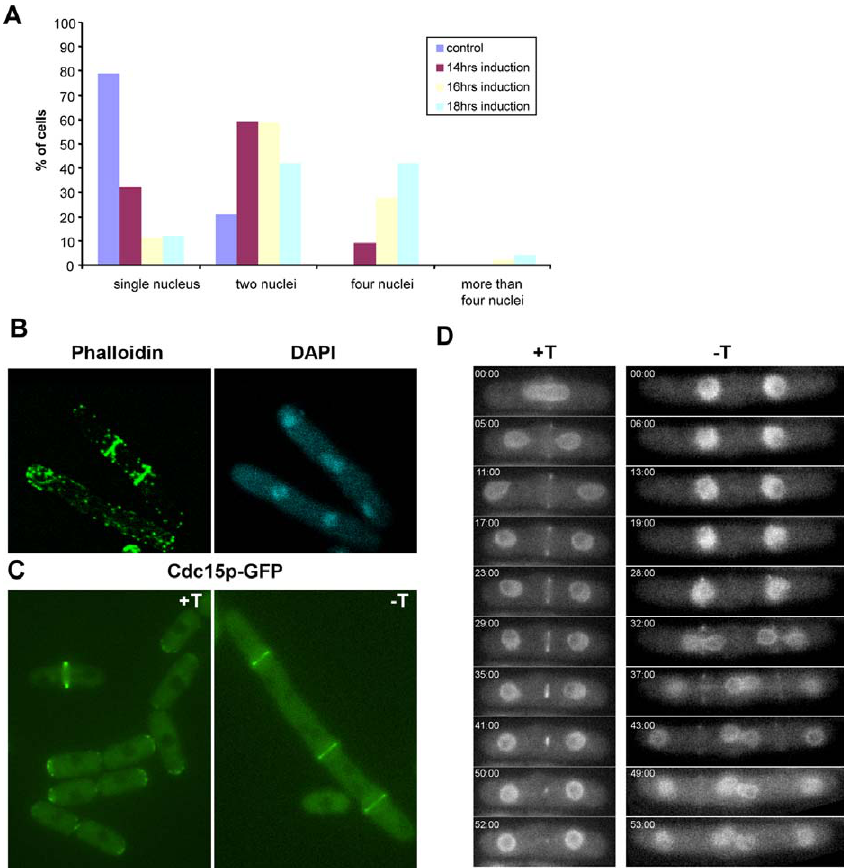
Figure 3. Actomyosin Rings Are Assembled, but Not Maintained, at the Division Site in Cells Overexpressing Nuc2p (A) Quantification of the number(s) of nuclei/cell and the frequency of their appearance upon overexpression of Nuc2p. Cells expressing Uch2p-GFP as a nuclear marker were used in the experiment. (B) Visualization of F-actin. Cells overexpressing Nuc2p were fixed and stained with phalloidin and DAPI to visualize the F-actin cytoskeleton and nuclei, respectively. (C) Visualization of Cdc15p. Cells carrying Cdc15p-GFP were induced to overexpress Nuc2p and visualized by fluorescence microscopy. þ T/ (cid:2) T indicates medium supplemented with or without thiamine. (D) Time-lapse fluorescence microscopy to image the dynamics of actomyosin ring assembly and constriction. Cells were grown in medium with or without thiamine and imaged by time-lapse microscopy. The nucleus and actomyosin ring were marked by Uch2p-GFP and Rlc1p-GFP, respectively. Scale bar, 5 l m.